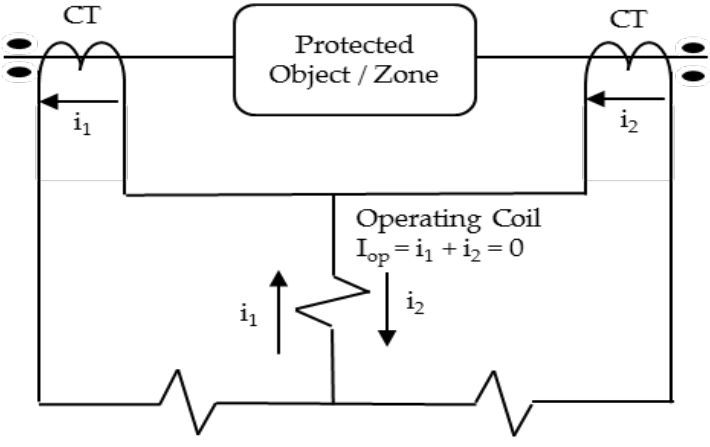
Figure 7. Operation concept of differential relay.